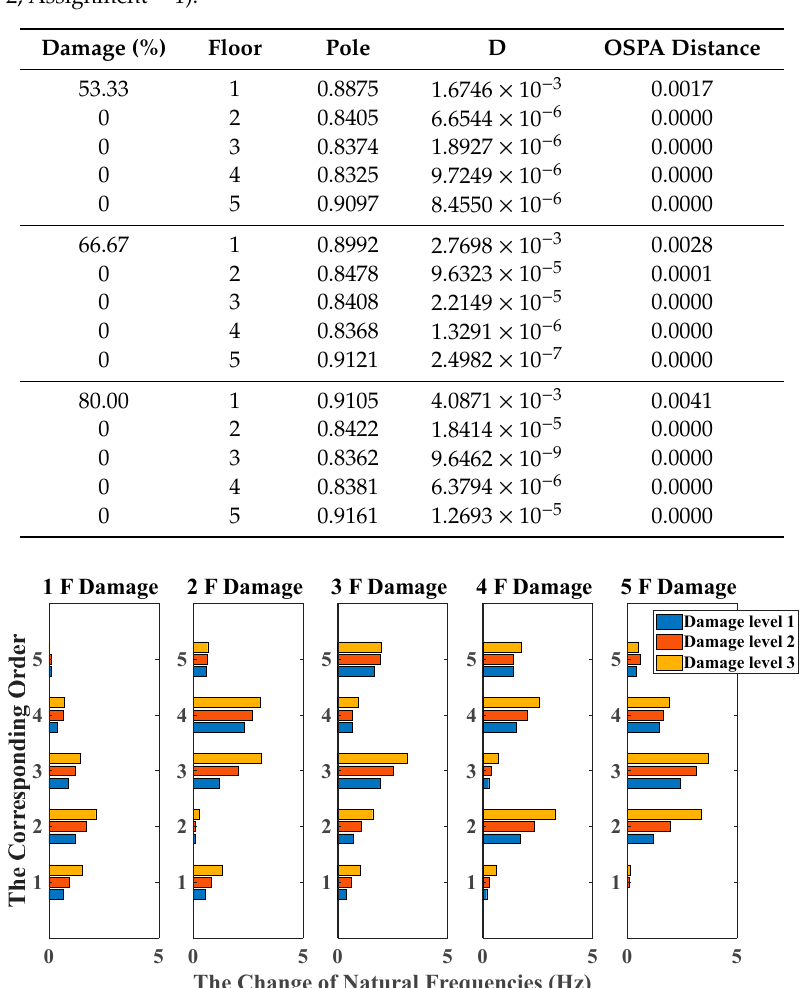
Table 4. OSPA distance and the corresponding parameters for the case of damage occurring on the first floor (sine sweeping-frequency excitation, autoregressive model, data length = 4000, AR order = 1, OSPA.p = 2, Assignment = 1).